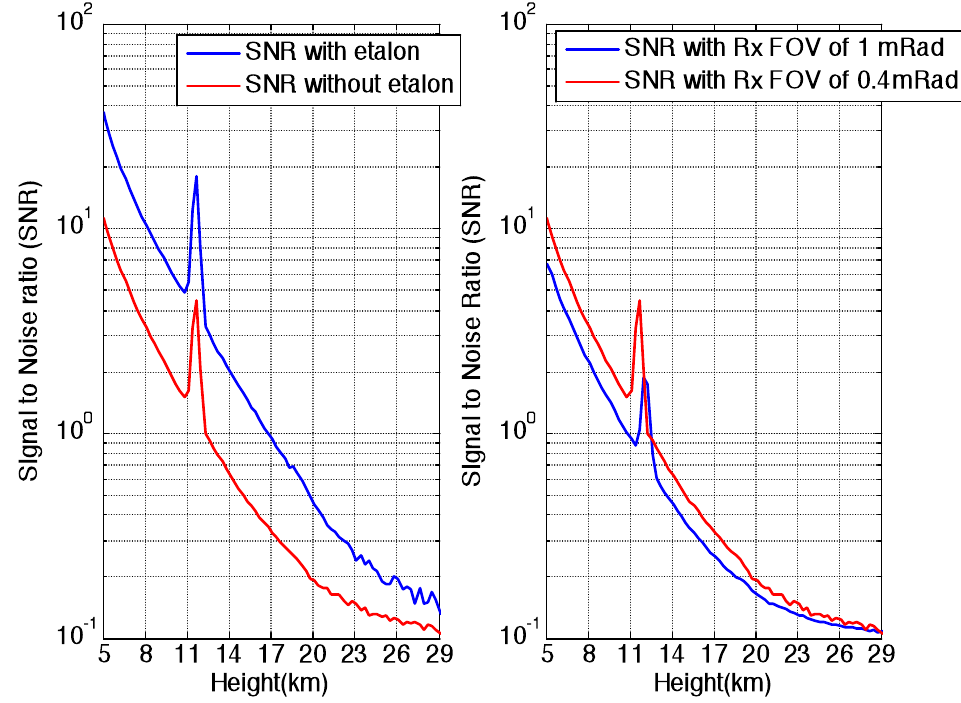
Figure 8. Height gain at 0733 hours on March 18, 2010, with the two techniques. The height coverage advantage is clear from the two techniques, where the SNR is one.